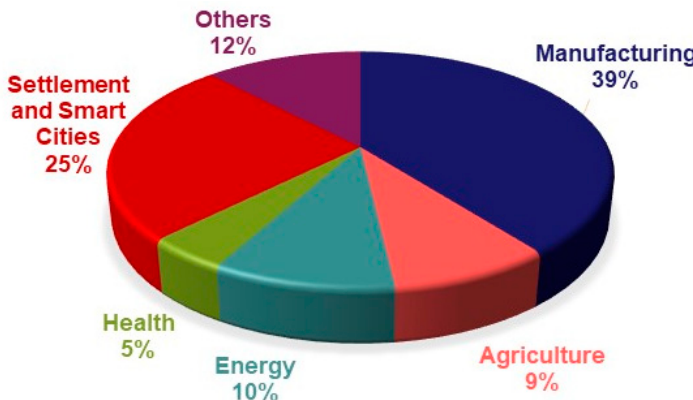
Figure 1. The graph of digital twin market distribution in 2020 [11].